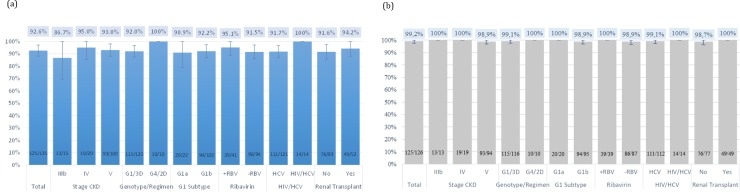
Overall SVR12 for each sub-group of patients studied.(a) SVR12 in the ITT population. The groups analyzed are: CKD stage, Genotype/Regimen, RBV use, coinfection and renal transplant. The overall ITT SVR12 was 92.6% (125/135; 95% CI 88.2–97.0) for patients receiving 3D/2D regimen. (b) SVR12 in the mITT population which includes only those patients in the ITT population excluding those patients whom SVR12 assessment data were missing (unknown) and those patients who discontinued. All percentages are over 98%.